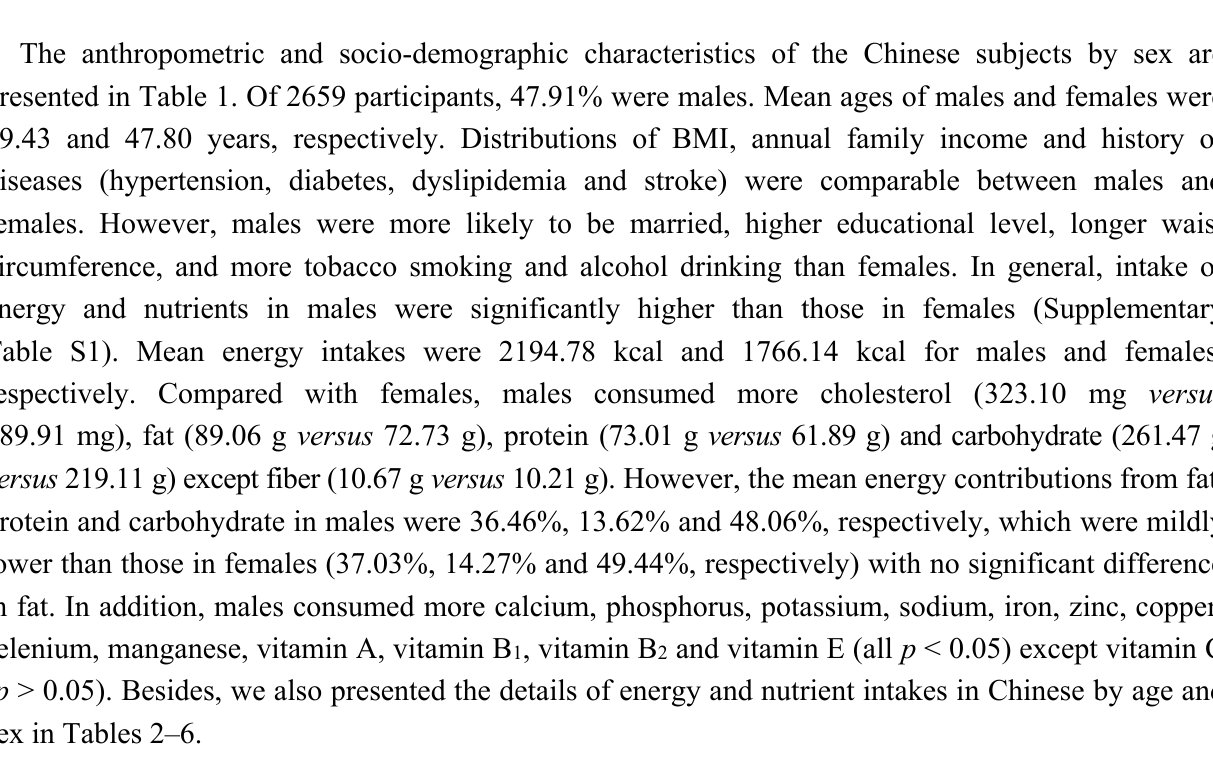
Table 1. The distributions of socio-demographic characteristics of study subjects by sex in the Chinese group ( N =